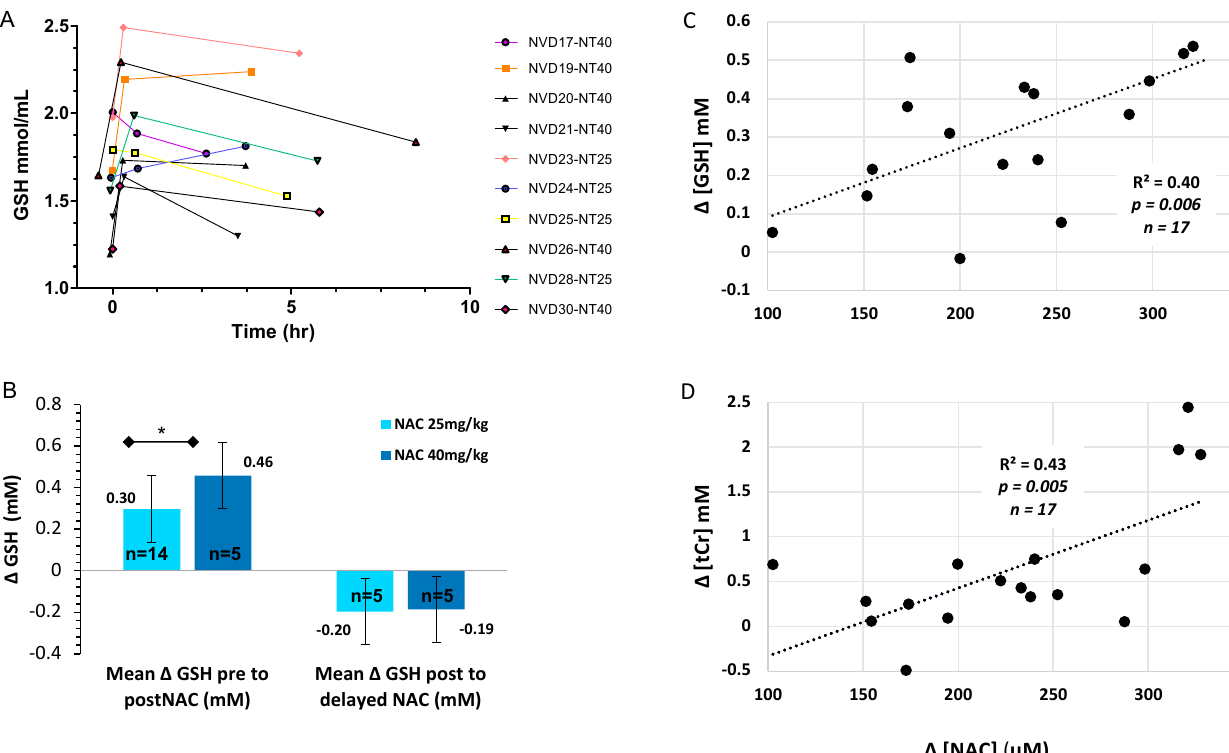
Table 3. MRS metabolite concentrations for all subjects, Mean (SD).